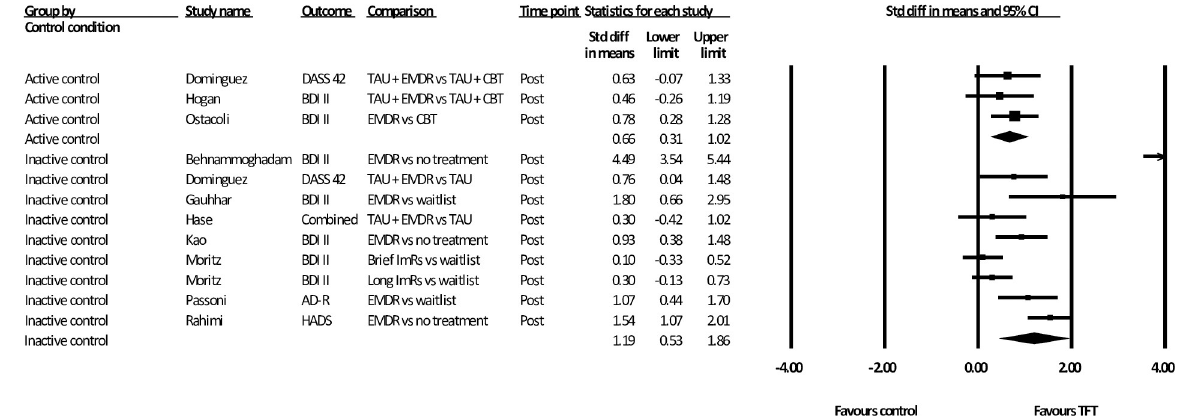
Fig 3. Subgroup analysis: Standardised effect sizes of trauma-focused treatments for depression compared to active and inactive control conditions.